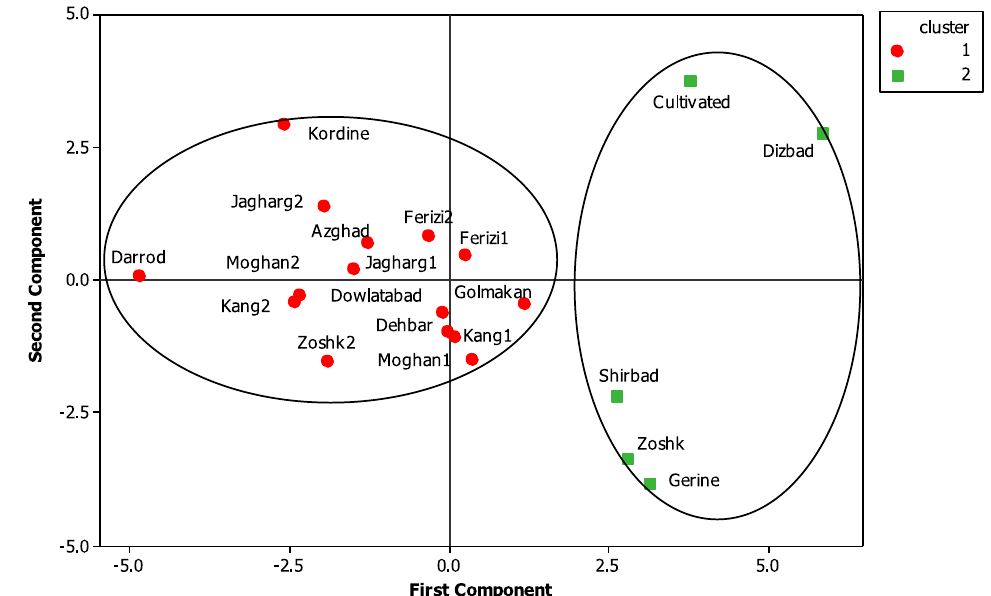
Fig. 2 Dendrogram of the 20 populations of Nepeta binaludensis resulting from the cluster analysis of the main essential oil constituents and climatic conditions based on Ward method